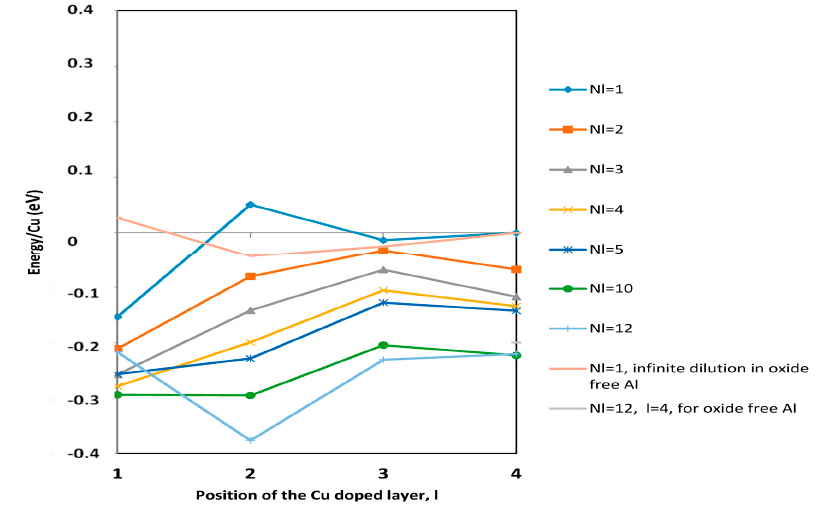
Figure 2. Energy of Cu segregation and aggregation/Cu atom (calculated with Formula (2)) in the Al(111) slab covered with the oxide film as a function of the location of Cu underneath the oxide-metal interface, in the layer l . l = 1 is the first layer underneath the metal oxide interface, and l = 4 is the fourth layer underneath the metal-oxide interface, as shown in Figure 1. Nl is the number of Cu atoms in the layer (see Formula (2)). Data obtained for the oxide-free Al(111) surface are also indicated. As stated in the text, the reference energy is the isolated Cu atom in the l = 4 layer, which is representative of the Cu infinite dilution in bulk Al.